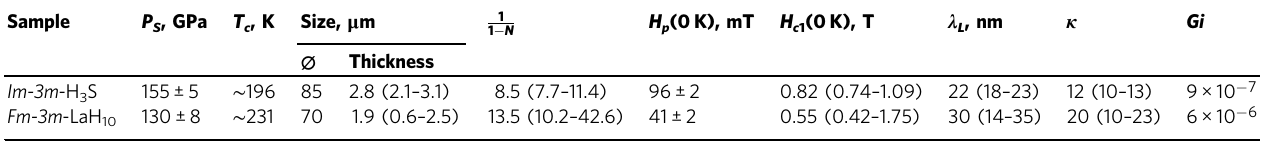
Table 1 Summary of estimated superconducting parameters for Im-3m -H 3 S and Fm-3m -LaH 10 at high pressure.